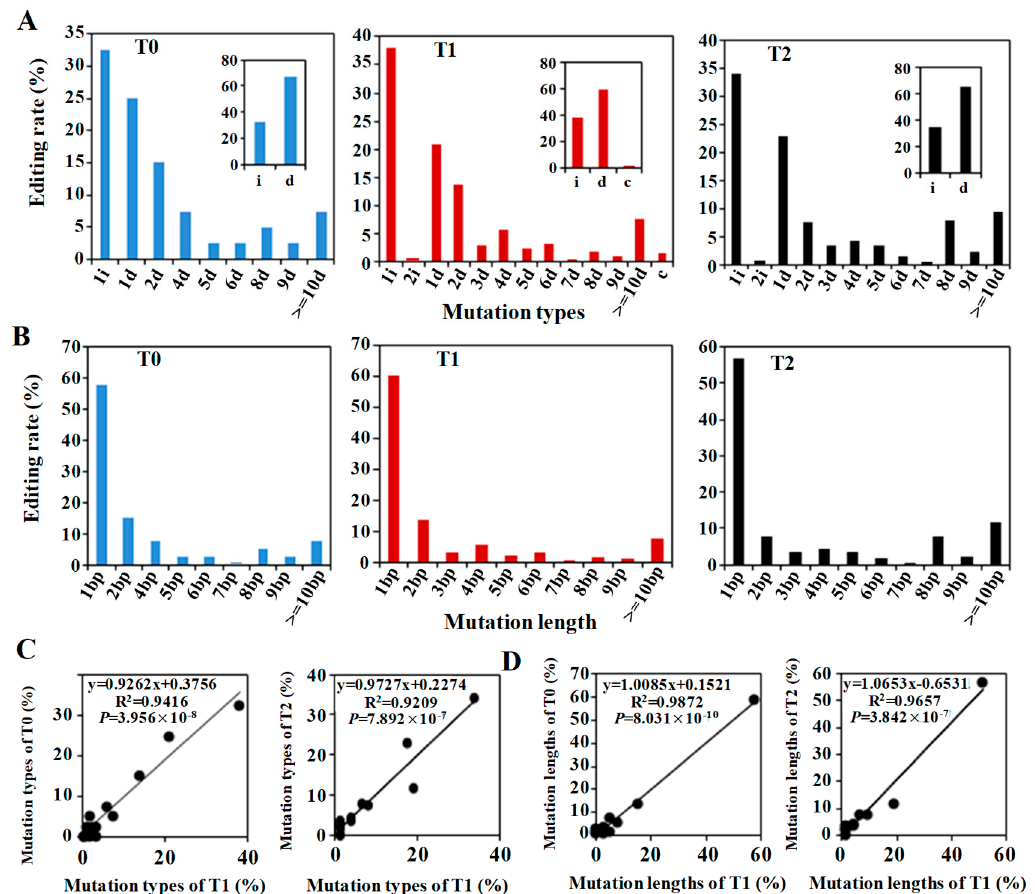
Figure 5. The distributions and correlations of the mutations across generations. ( A ) Distribution of mutation types in the T0, T1 and T2 generations. ( B ) Distribution of the mutation lengths in T0, T1 and T2 generations. ( C ) Correlation of mutation type frequency between the T0 and T1 generations. ( D ) Correlation of mutation type frequency between the T1 and T2 generations. The correlation was analyzed by Pearson’s method. i, insertion; d, deletion; c, combined mutation types.